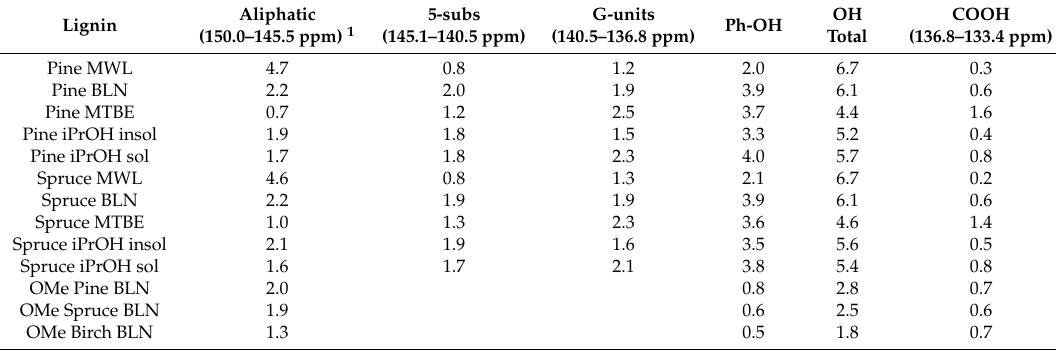
Table 2. Amount of free hydroxyl groups in mmol/g based on 31 P NMR analysis.